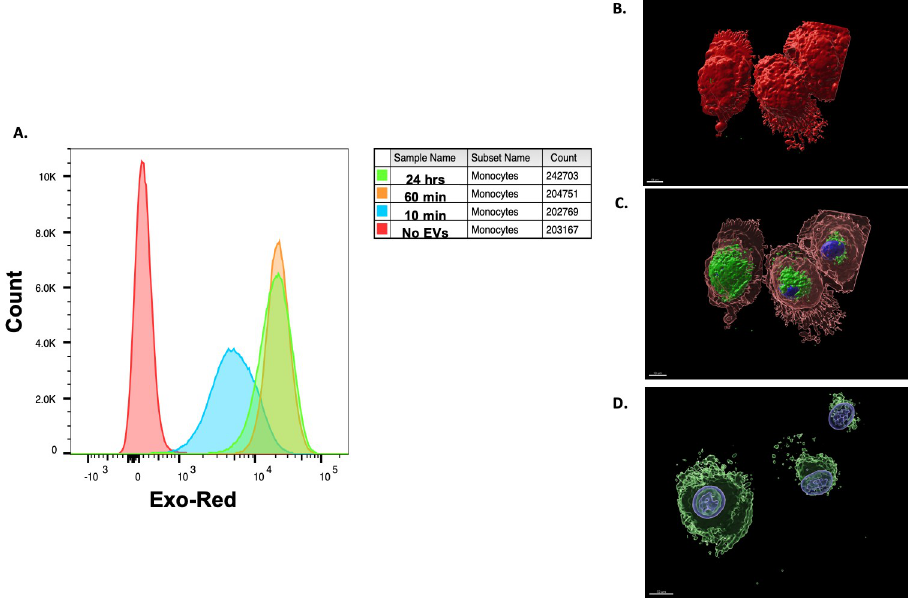
Fig 3. Internalization of mf-derived EVs by human DC. THP-1 cells were incubated for 10 minutes, 60 minutes, or 24 hours with mf-derived EVS that were stained with Exo-Red dye. EV uptake was assessed by flow cytometry (A). Human monocyte derived dendritic cells were co-cultured with B . malayi mf-derived EVs for 72 hours at 37˚C in 5% CO 2 . The dendritic cells were labelled with PKH26 (red) and counterstained with VECTASHIELD Hardset Antifade Mounting Media with DAPI (blue) to visualize the nuclei. The parasite EVs were labelled with PKH67 (green). The merged image demonstrates that no parasite-derived EVs remain bound on the surface of the cell (B). The internalized vesicles appear diffused throughout the cytoplasm of the cells (C), with some EV products potentially translocating into the nucleus (D). All images were captured using Zeiss 780. The assay was performed three times.